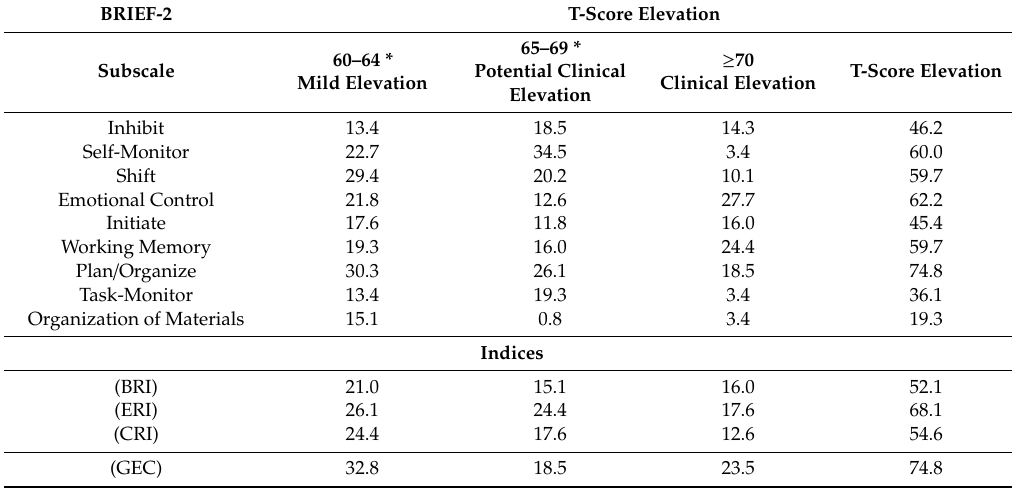
Table 4. The Parent-Rated BRIEF-2 Base Rates for the Elevated T-Scores for the Children with autism spectrum disorder